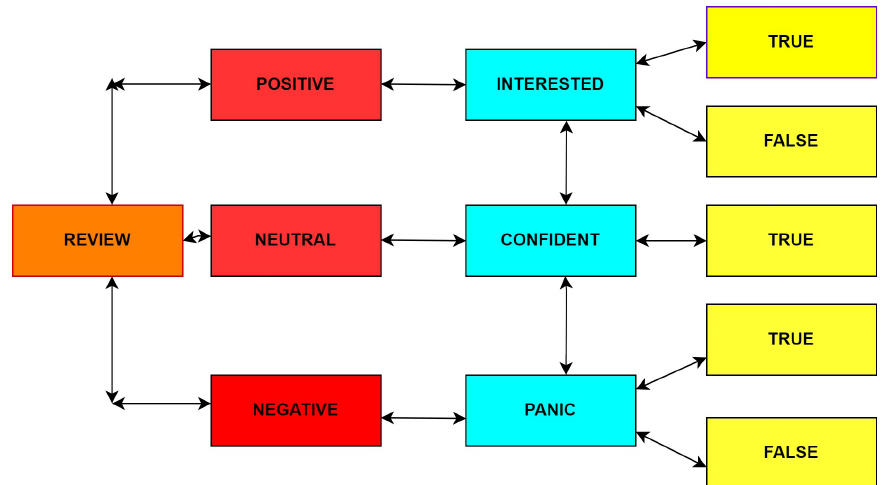
Figure 7. Decision tree of a